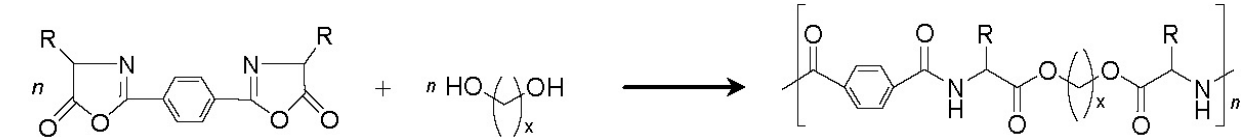
Figure 38. Synthesis of AABBP on the basis of